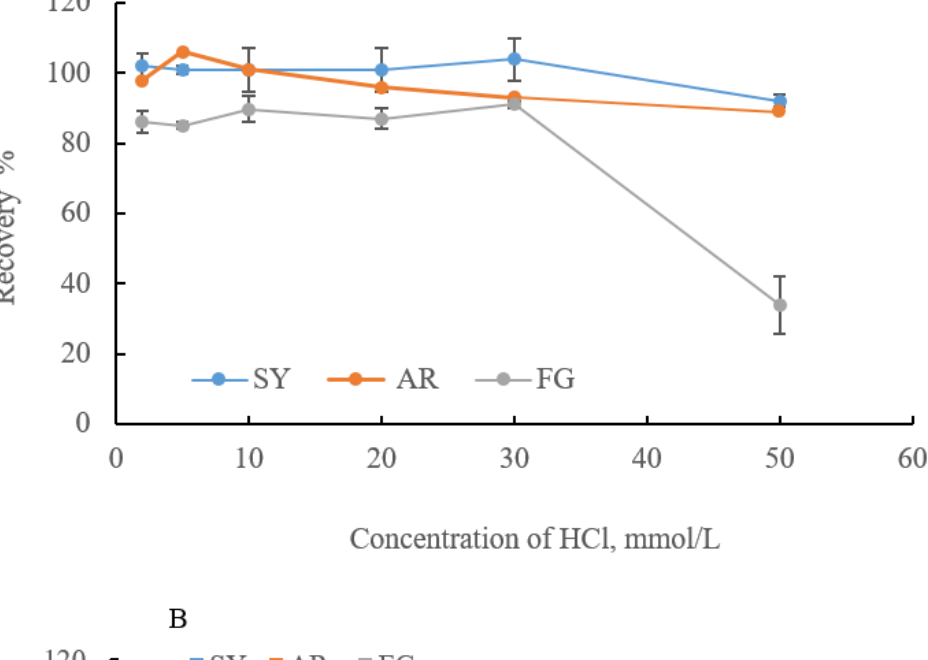
O -EA, 1 µg/mL of dyes containing 25 mL solution, 3 4 O -EA ( 100 mg Fe O -EA, 1 µg/ 3 4 3 4